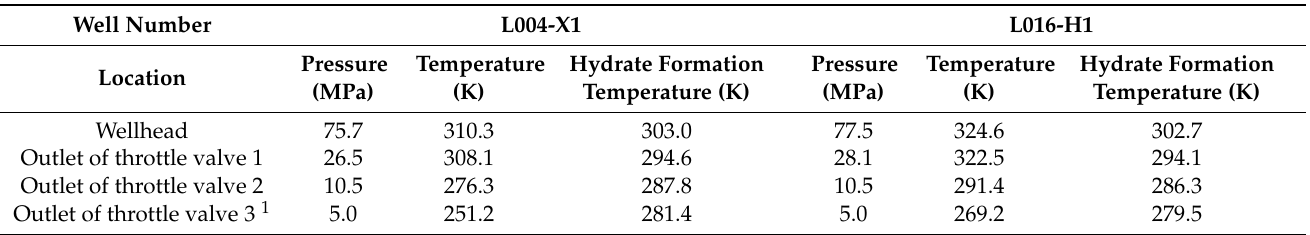
Table 8. Optimized throttling process parameters and hydrate formation temperature for wells L004-X1 and L016-H1.